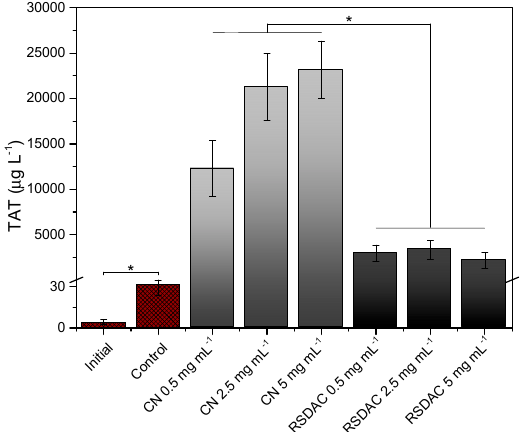
Figure 3. Levels of thrombin-antithrombin complexes after whole blood incubation with Cladophora nanocellulose (CN) and RSDAC at 37 °C for 60 min. Data represent mean ± standard error of the mean for n = 6. Statistically significant differences between sample groups are indicated by * ( p < 0.05). All Cladophora nanocellulose and RSDAC values were significantly different from initial sample and control.